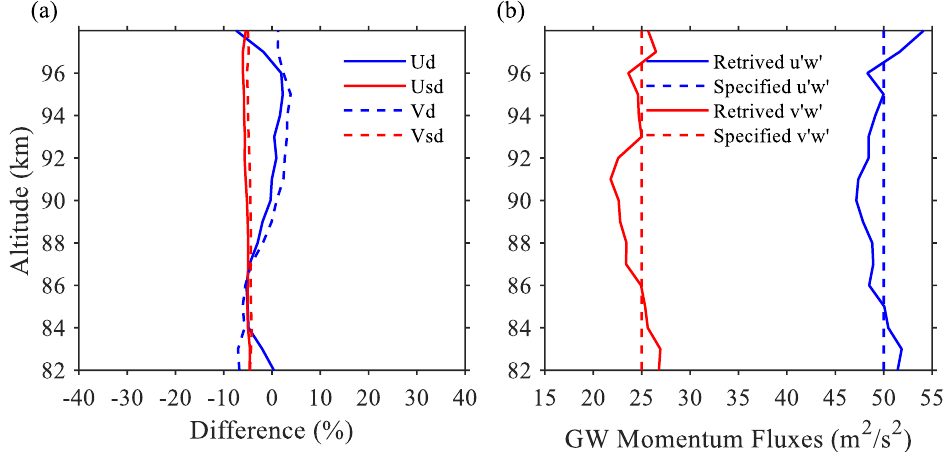
Figure 7. ( a ) Differences of the amplitudes of the diurnal (red lines) and semidiurnal (blue lines) tides, between the estimated ones and the specified ones for case 4, using the angular information detected in July 2012. The solid and dashed lines are for the zonal and meridional direction, respectively ( b ).